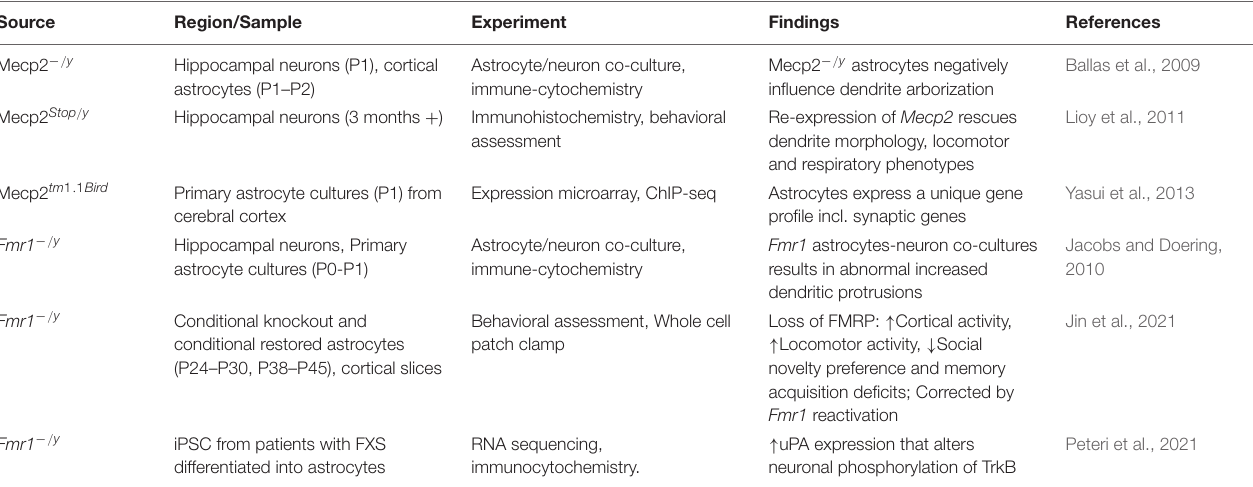
TABLE 6 | Astrocyte function in Rett syndrome and Fragile X